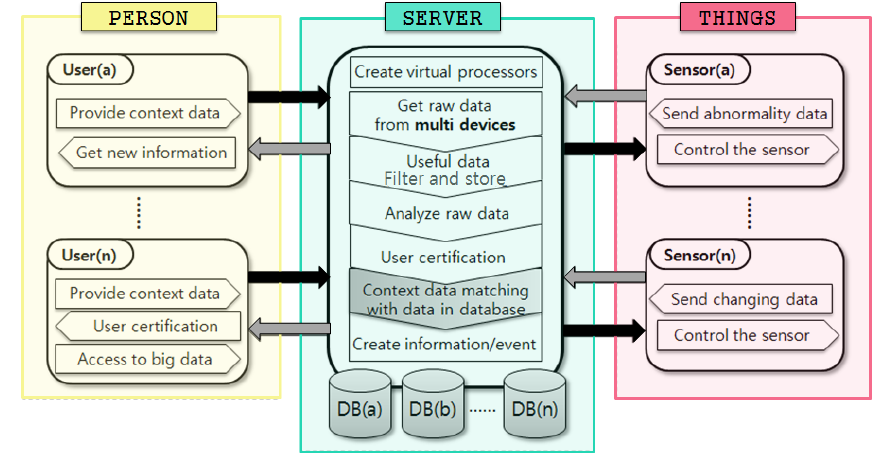
Figure 3. Flow diagram for the contextual information system.